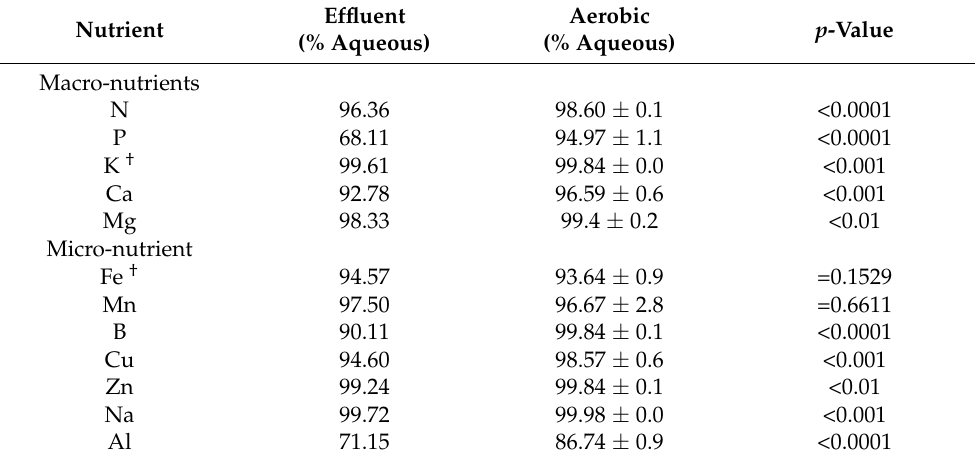
Table 3. Increase of total nutrient concentrations in aqueous form (and available for plant uptake) in tilapia effluent after treatment. Mean percent ± SD of total nutrients in aqueous form shown before and after treatment. Statistical significance of untreated effluent and aerobic solution described by p